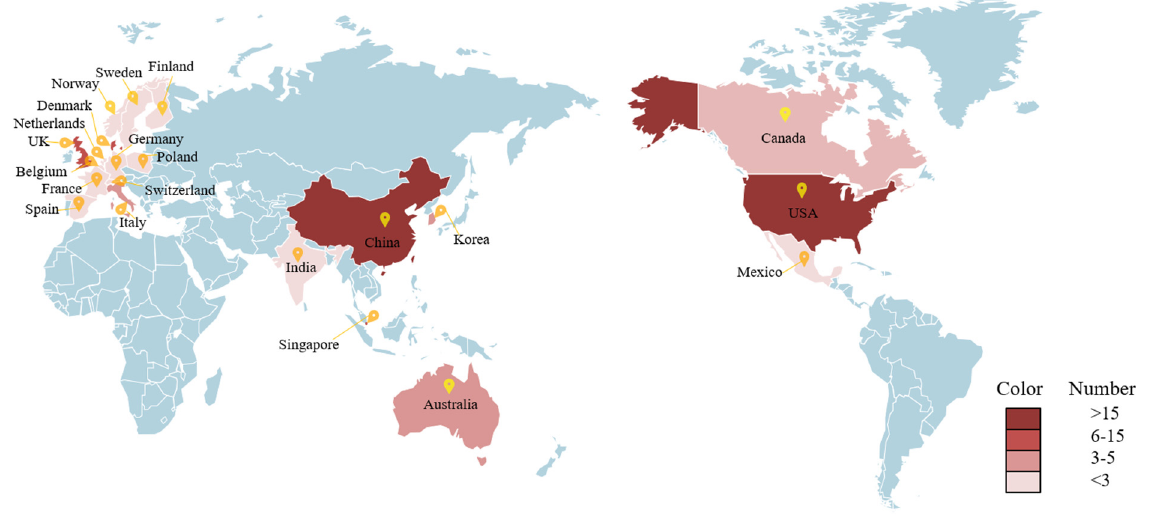
Figure 4. Geographical distribution of the literature.